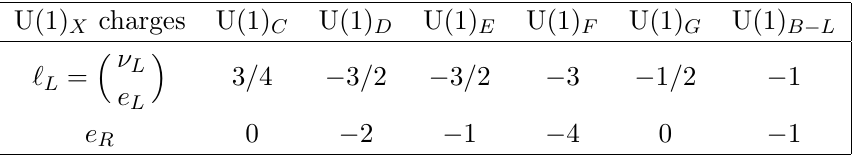
Table 1 . Anomaly free charge assignments in U(1) X models [79]. Those were designed to explain neutrino masses via the seesaw mechanism and address the (cid:13)avor problem in two Higgs doublet